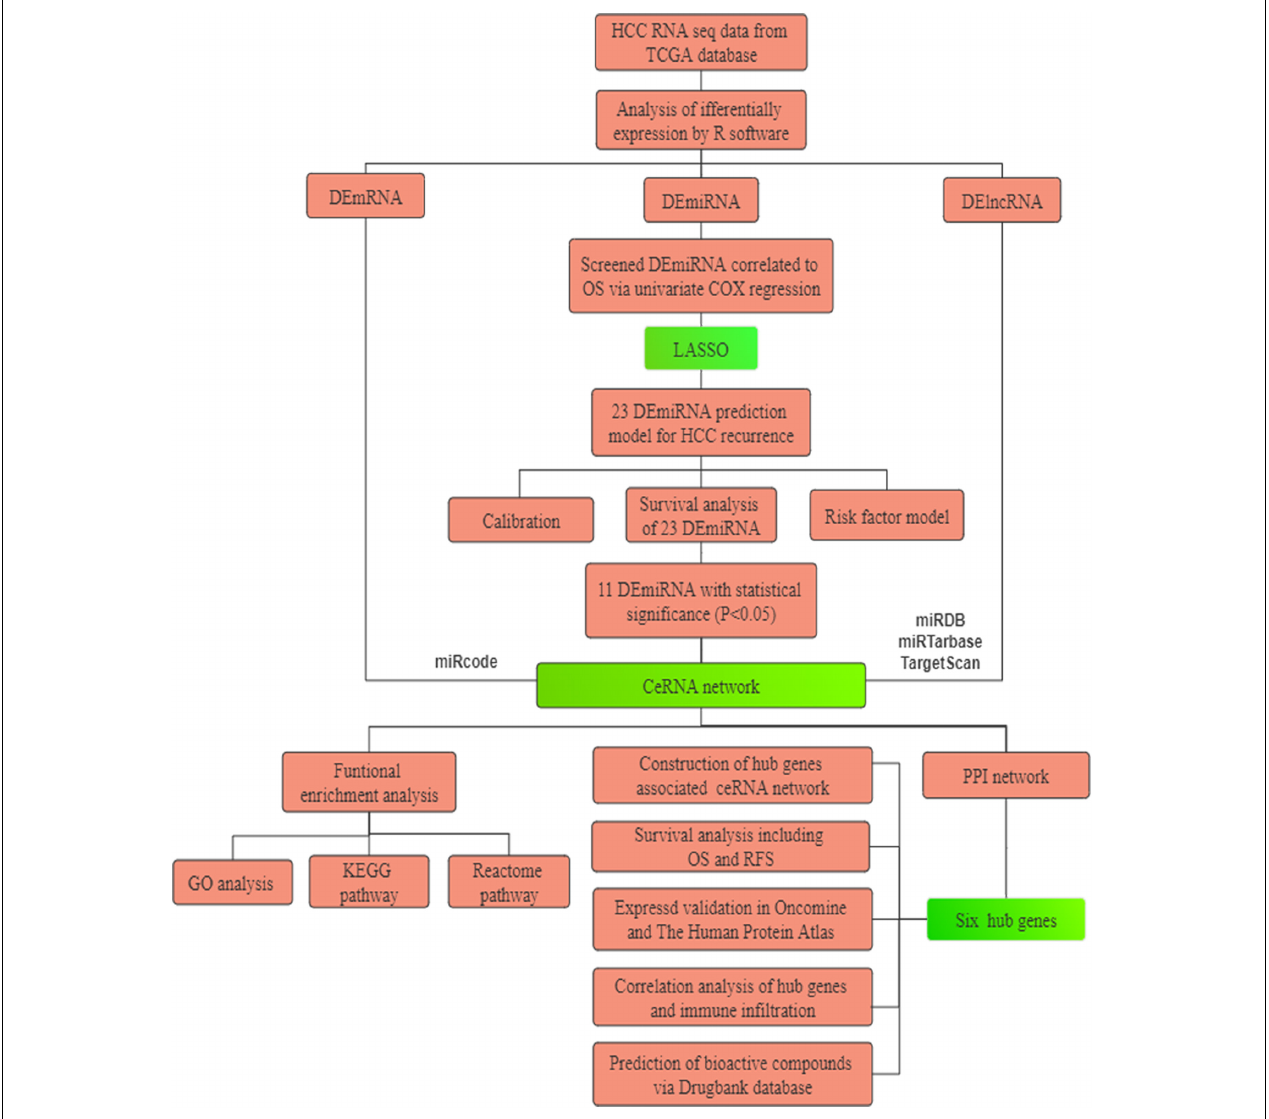
FIGURE 1 | The flowchart of the present research. HCC: hepatocellular carcinoma. TCGA: The Cancer Genome Atlas. PPI: protein–protein interaction. GO: Gene Oncology. KEGG: Kyoto Encyclopedia of Genes and Genomes. ceRNA: competing endogenous RNAs. LASSO: the least absolute shrinkage and selection